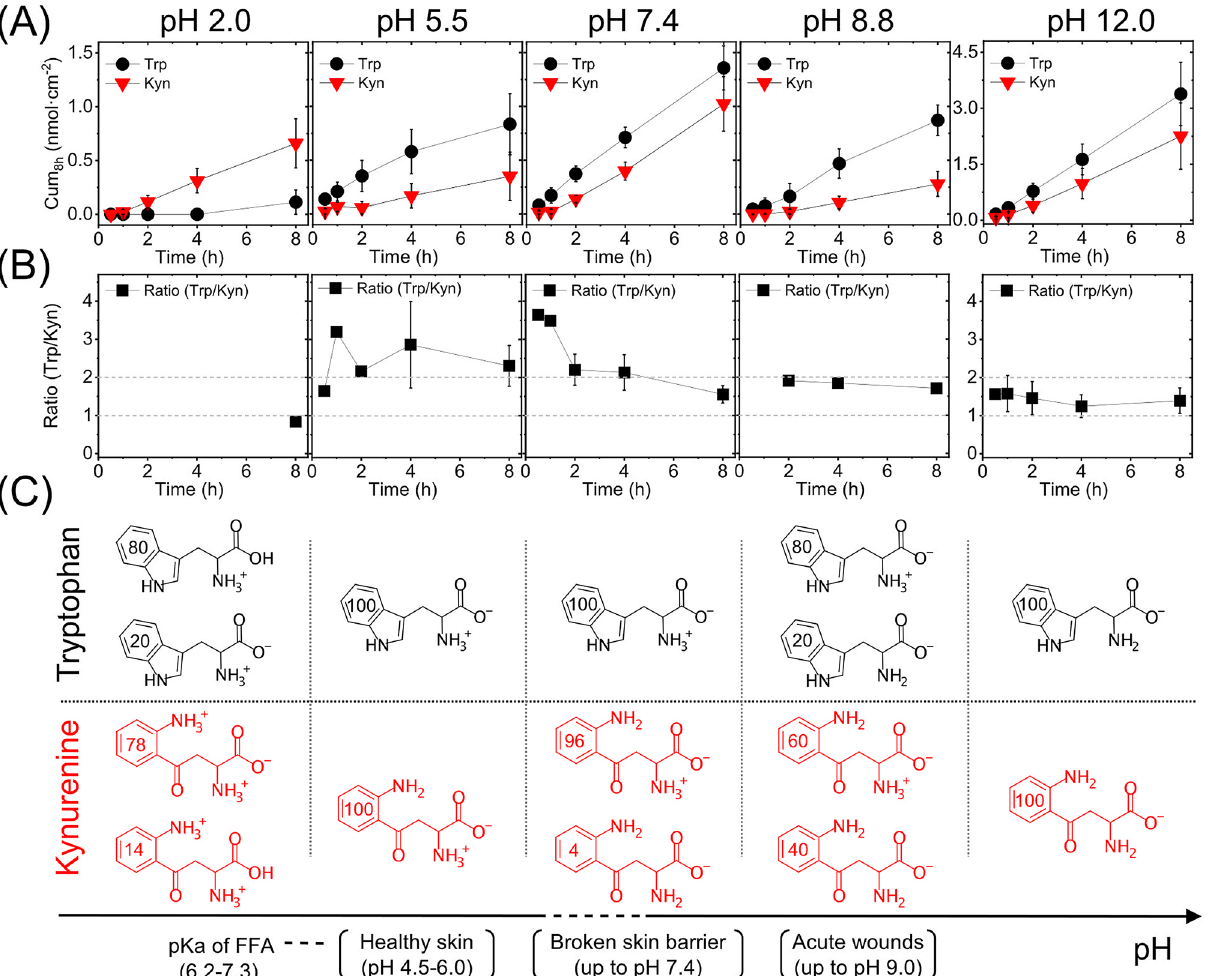
Figure 2. ( A ) Cumulative permeated amount of Trp and Kyn through skin as a function of pH ( n = 6). ( B ) Trp/ Kyn ratio, corresponding to the data in ( A ). ( C ) Illustration of the dominating ionization species of Trp and Kyn at different pH values (numbers in the aromatic rings are in %). Values of p K a of free fatty acids (FFA) in SC lipid model mixtures are from Ref. 47 . pH Analyte Cum 8h (nmol cm −2 ) Trp/Kyn (8